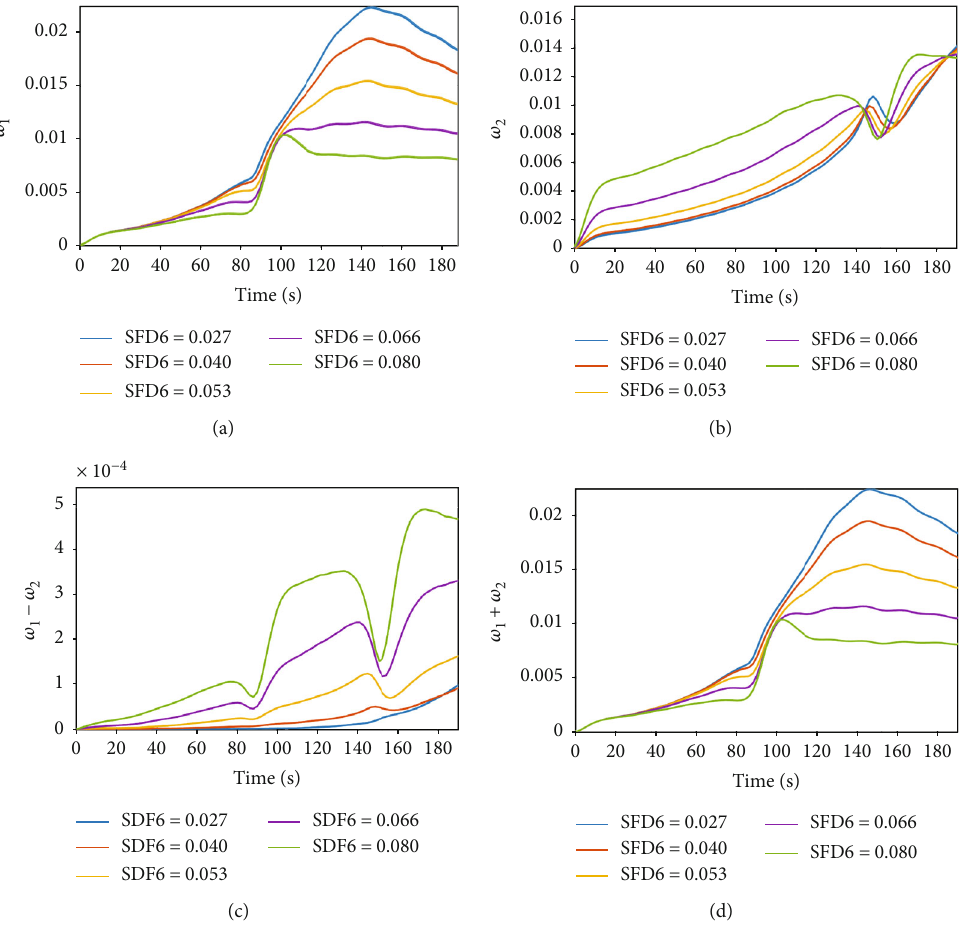
ω ω − ω ω + ω 1 ; (b) 2 ; (c) 1 2 ; (d) 1 2